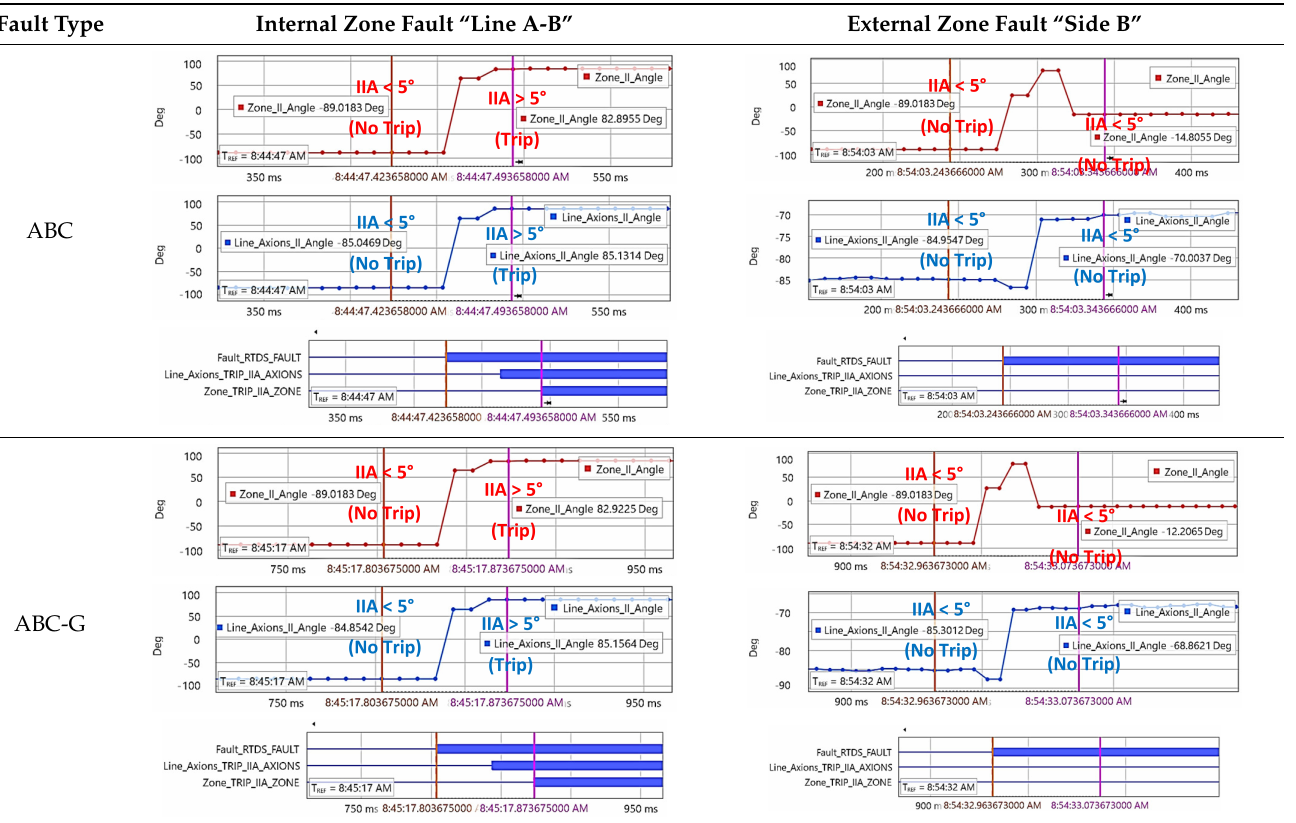
Table 7. IIA Zone behaviour without RES (Part 2 of 2).